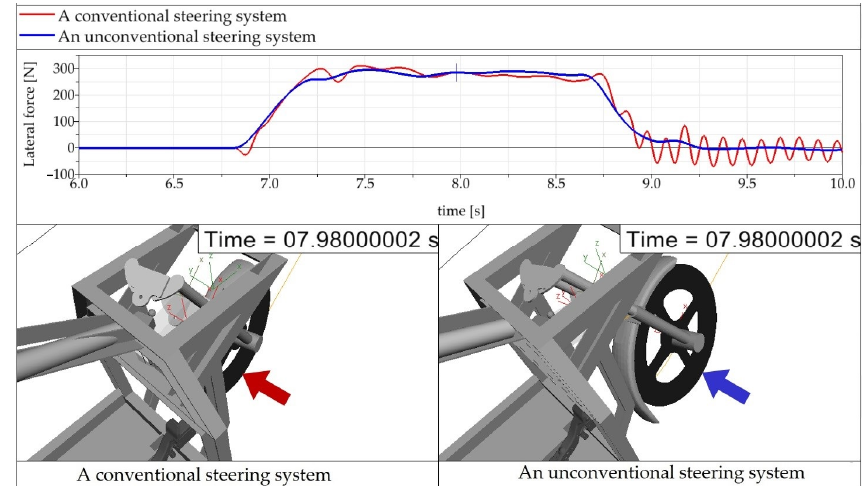
Figure 8. Total lateral wheel force of the front steered wheel at the time of riding through a left- hand bend by a three-wheeler with a conventional steering system and with an unconventional steering system.